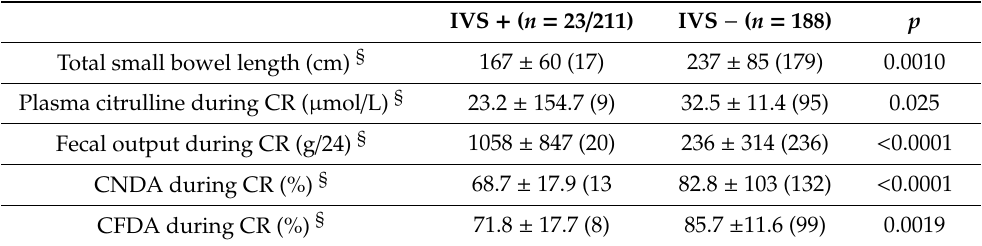
Table 3. Patients who required intravenous supplementations (IVS) for more (IVS+) than 14 days or less (IVS–) after the start of CR.